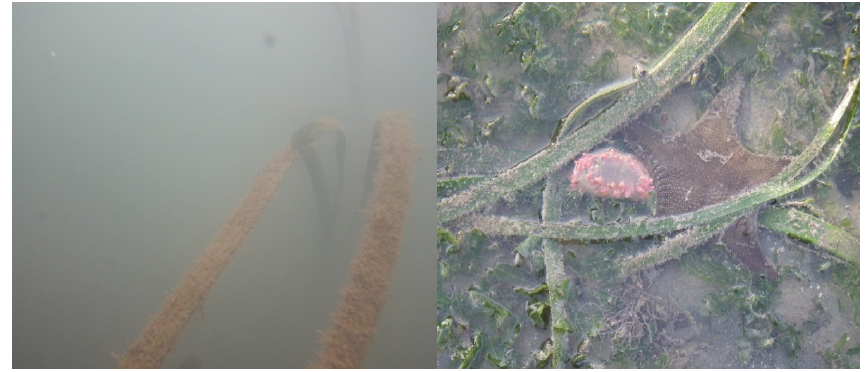
Figure 4. Typical mixed seagrass species on Merambong shoal during submergence seen from underwater video ( left ) and exposed ( right ).